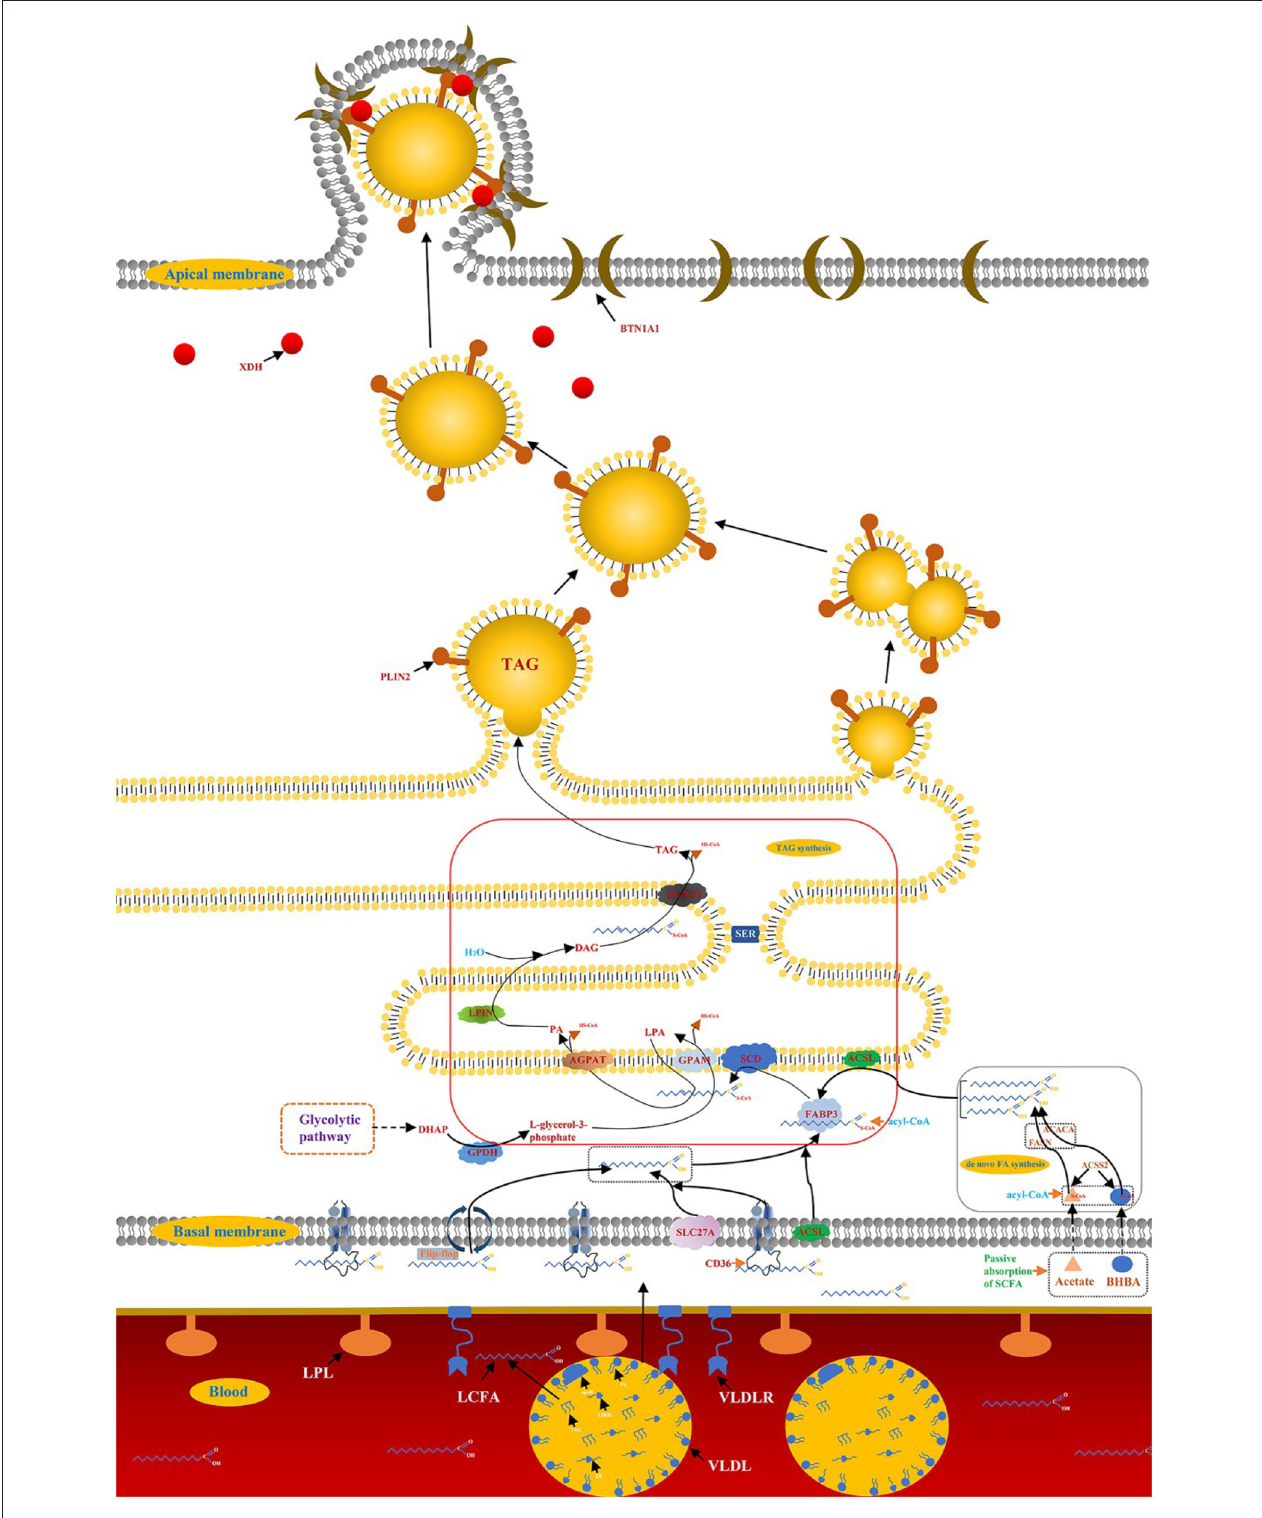
FIGURE 1 | Synthesis of milk fat in ruminants. A detailed description of the model is reported in the manuscript.